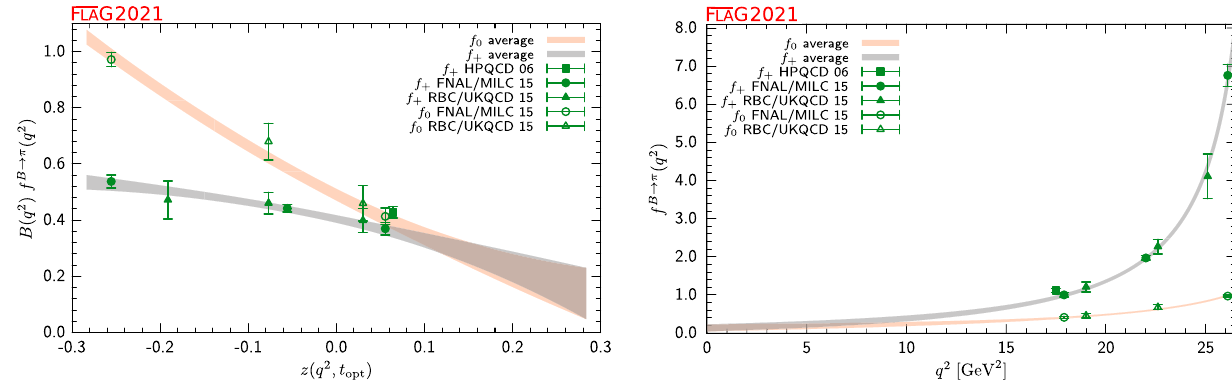
Fig. 31 The form factors f + ( q 2 ) and f 0 ( q 2 ) for B → π(cid:6)ν plotted versus z (left panel) and q 2 (right panel). In the left plot, we removed the Blaschke factors. See text for a discussion of the data set. The grey and salmon bands display our preferred N + = N 0 = 3 BCL fit (five parameters)